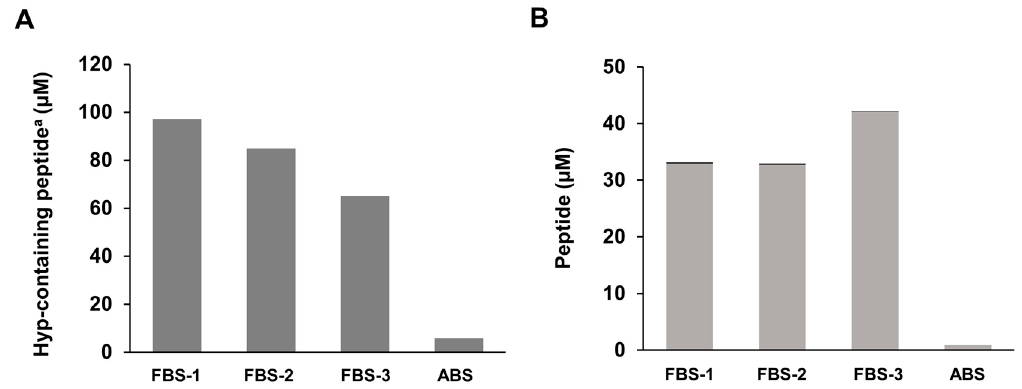
Figure 2. Contents of hydroxyprolyl peptide in commercially available fetal bovine serum (FBS) and adult bovine serum (ABS): ( A ) Hyp-containing peptide; ( B ) content of Pro-Hyp ( ■ ) and Hyp-Gly ( ■ ); a peptide form of Hyp.